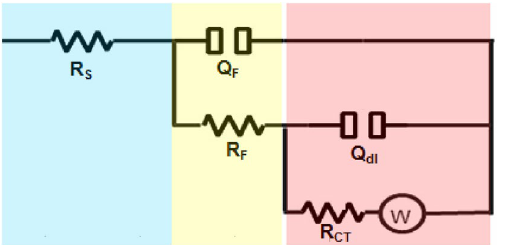
Figure 3. Equivalent circuit model used to fit the impedance measurement data.